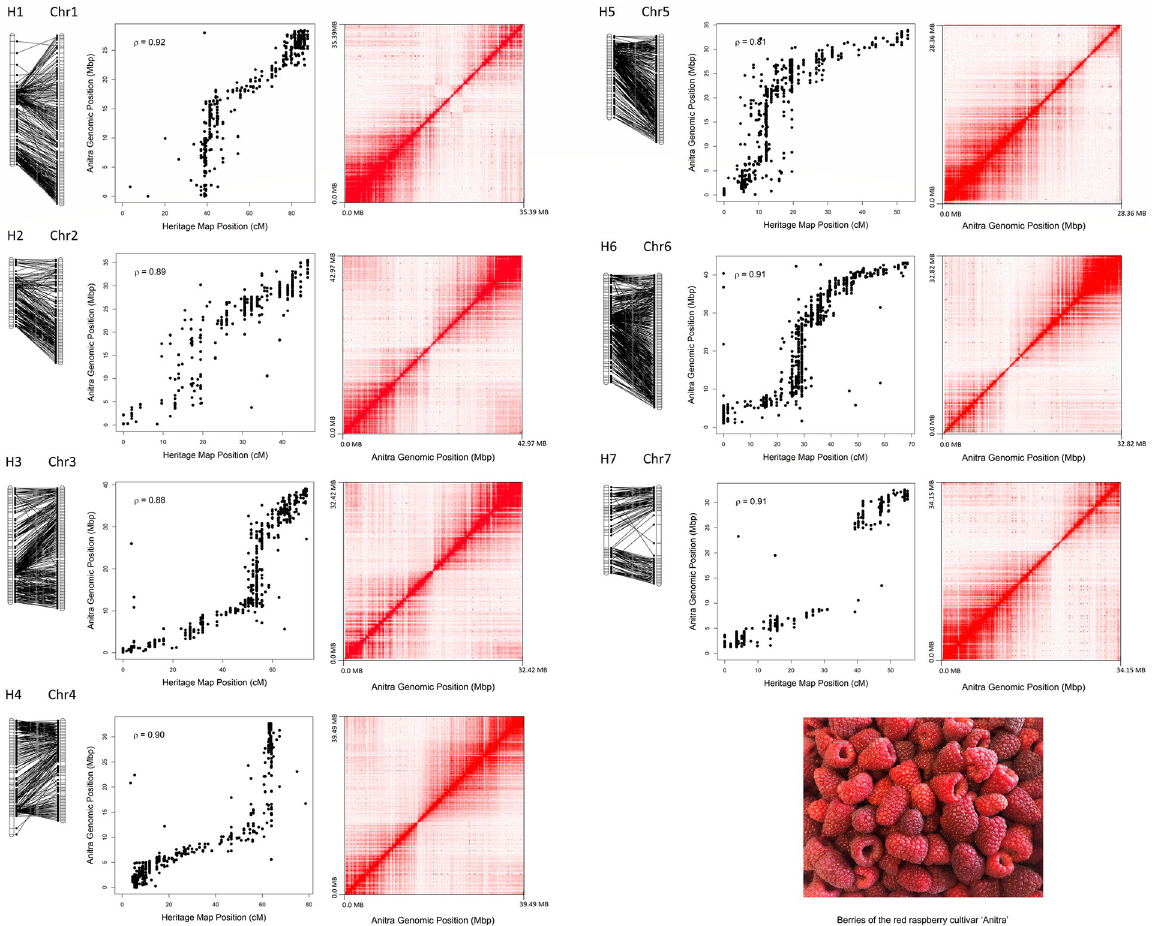
Fig 1. The seven chromosomes of the genome of R . idaeus ‘Anitra’. Genetic and physical positions of the 4,948 molecular markers on the reconstructed chromosomes of the ‘Anitra’ genome and the ‘Heritage’ genetic linkage map of [7] (left panels). Scatter plots showing the physical positions of the same molecular markers on each ‘Anitra’ chromosome (Chr) ( x axis) in relation to the ‘Heritage’ map positions ( y axis) where Rho ( ρ ) is the Pearson correlation coefficient for the associations (central panels). Hi-C intrachromosomal contact maps for each ‘Anitra’ chromosome are given in the right panels. The intensity of pixels represents the proportion of Hi-C links within 400-kb windows along each chromosome plotted on a logarithmic scale.